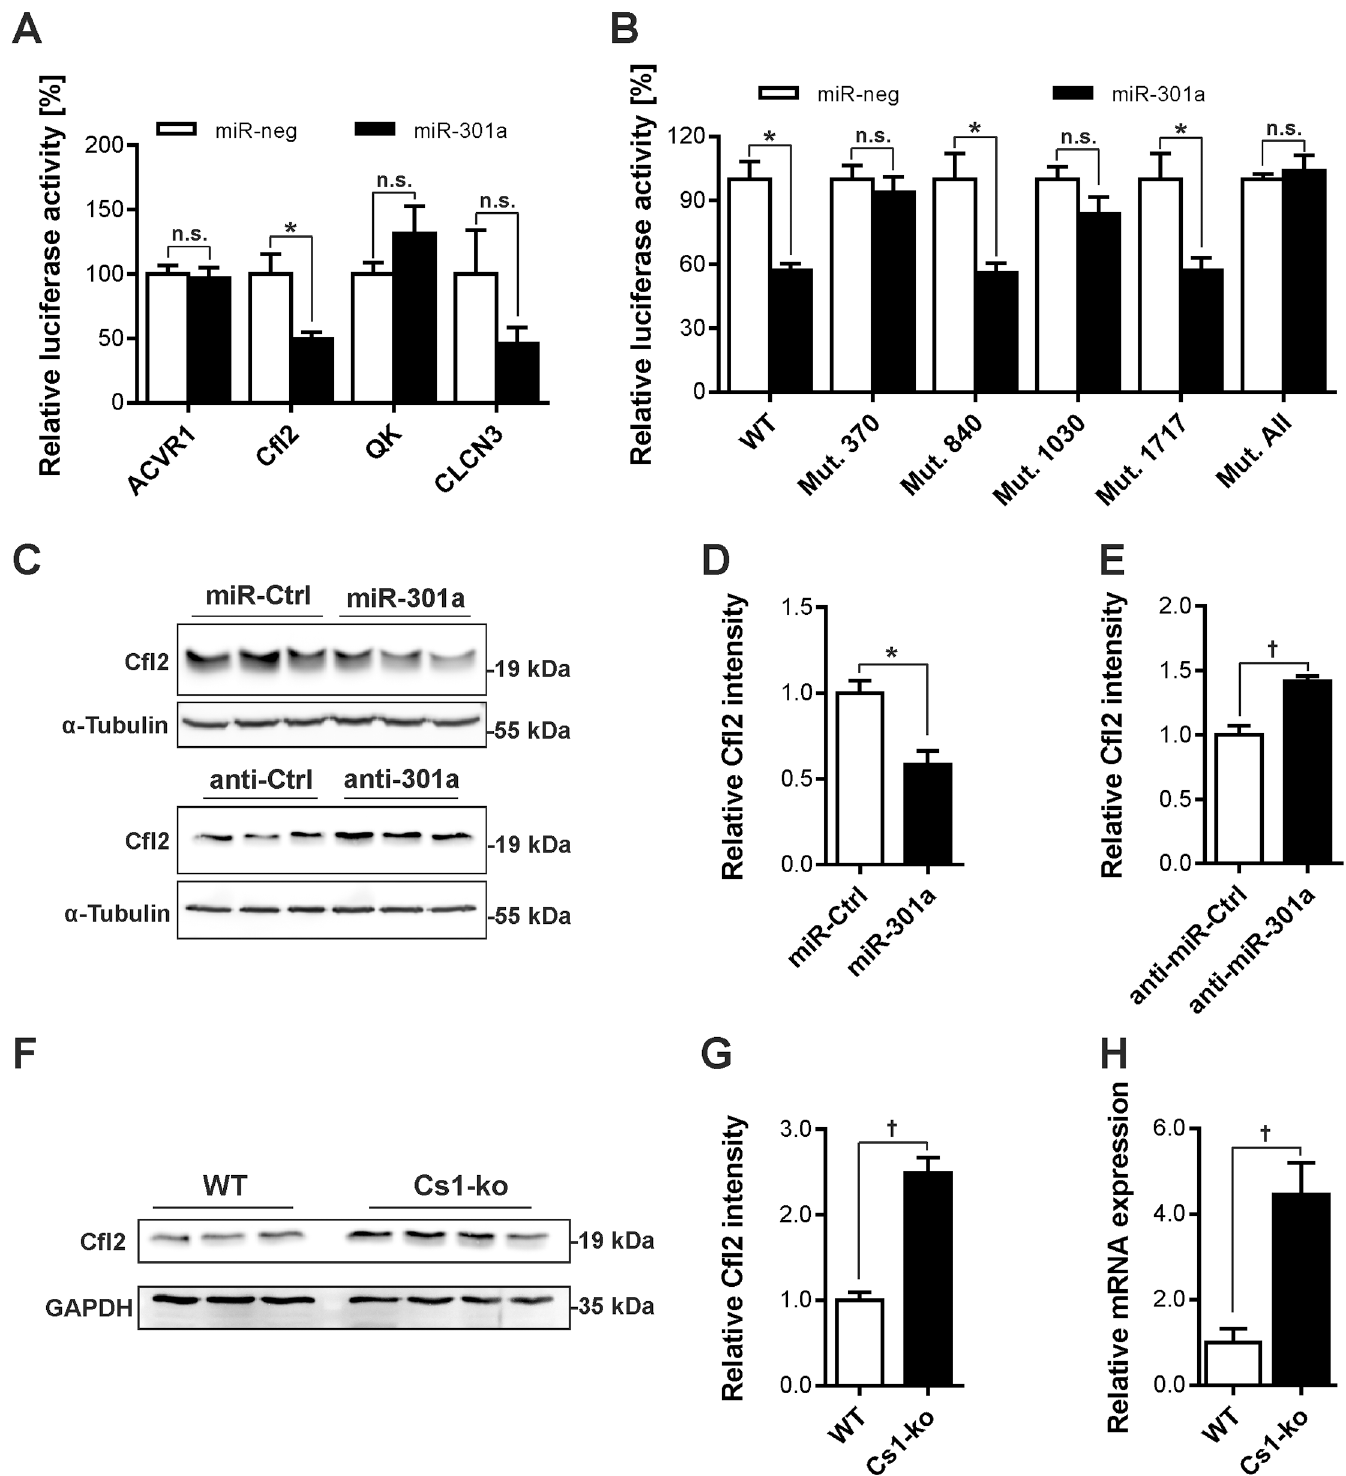
Fig 3. Cofilin-2 is a target of miR-301a. ( A ) We selecteda subset of the targets identified through onlinemicroRNAtarget databasesearch, including Cofilin-2(Cfl2), Activin A ReceptorType 1 (ACVR1), Quaking (Qk), and ChlorideVoltage-Gated Channel3 (CLCN3). Putative 3’UTR bindingsites from these targets was evaluatedusing pmirGLO Dual-Luciferase miRNA Target Expression Vector and assay system and found that only Cfl2 was a possible target (N = 6). ( B ) Cfl2 3’UTR has 4 putative bindingsites (detailedin S1A–S1D Fig), which we mutated using site directed mutagenesis to confirm which of